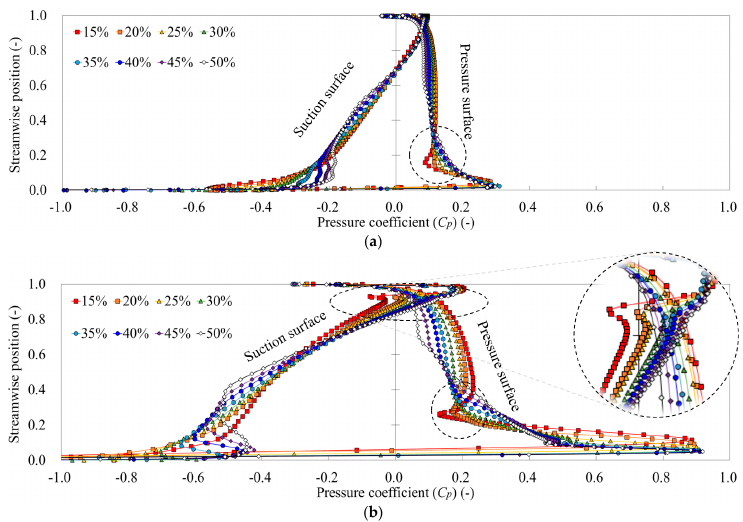
Figure 21. Blade loading curves with di ff erent maximum thickness positions ( Φ / Φ des = 1.0): ( a ) hub span; ( b ) shroud span.